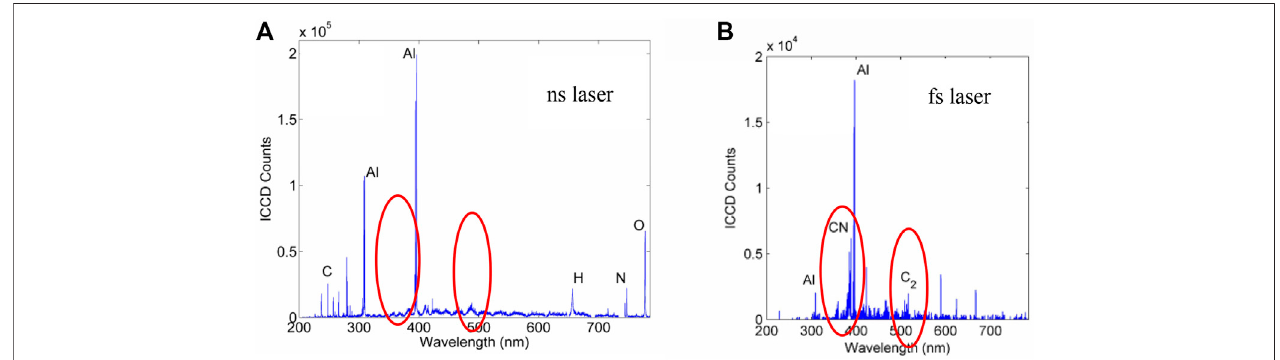
FIGURE 3 | (A) Nanosecond LIBS signal obtained from TNT on an aluminum substrate. The detection gate delay and width values were 1 and 2 µs, respectively. (B) Femtosecond LIBS signal obtained from TNT on an aluminum substrate, over the complete detection wavelength range. The detection gate delay and width values were 100 ns and 1 µs, respectively [34].